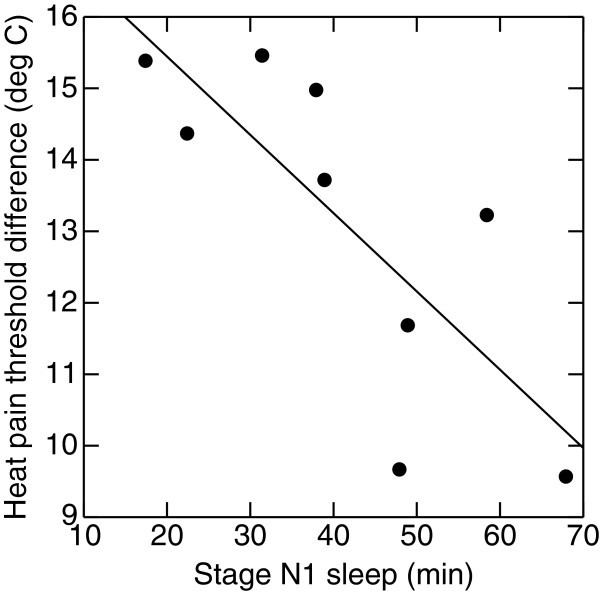
Preictal migraine subgroup. High levels of superficial stage N1 sleep is associated with relative heat-pain hyperalgesia (age-adjusted r=−0.80, p=0.02).